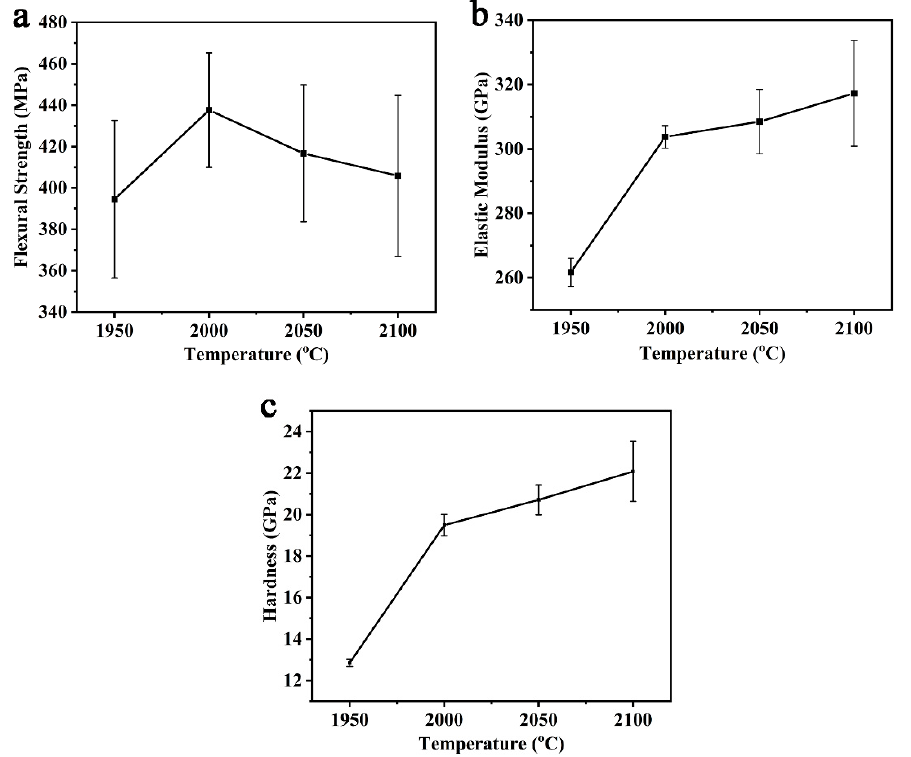
Figure 5. Mechanical properties of P70Z15A15 at different temperatures: flexural strength ( a ); elastic modulus ( b ); Vickers hardness ( c ).